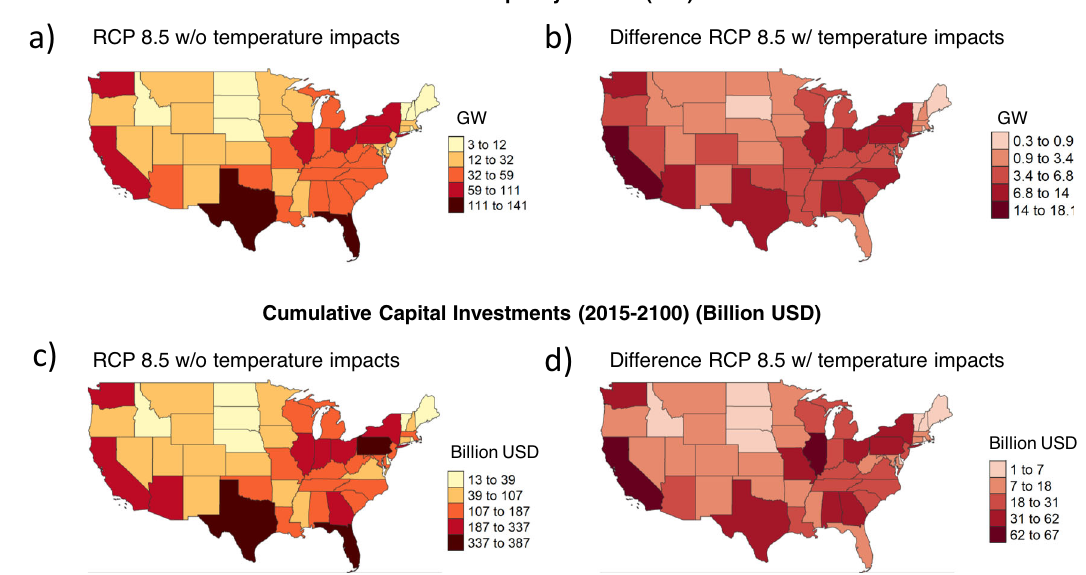
Fig. 4 Spatial distribution by state of install capacity (GW) and cumulative capital investments (billion USD) in 2100. a 2100 installed capacity under RCP 8.5 w/o temperature impacts scenario. b Difference in installed capacity in RCP 8.5 w/ temperature impacts scenario relative to RCP 8.5